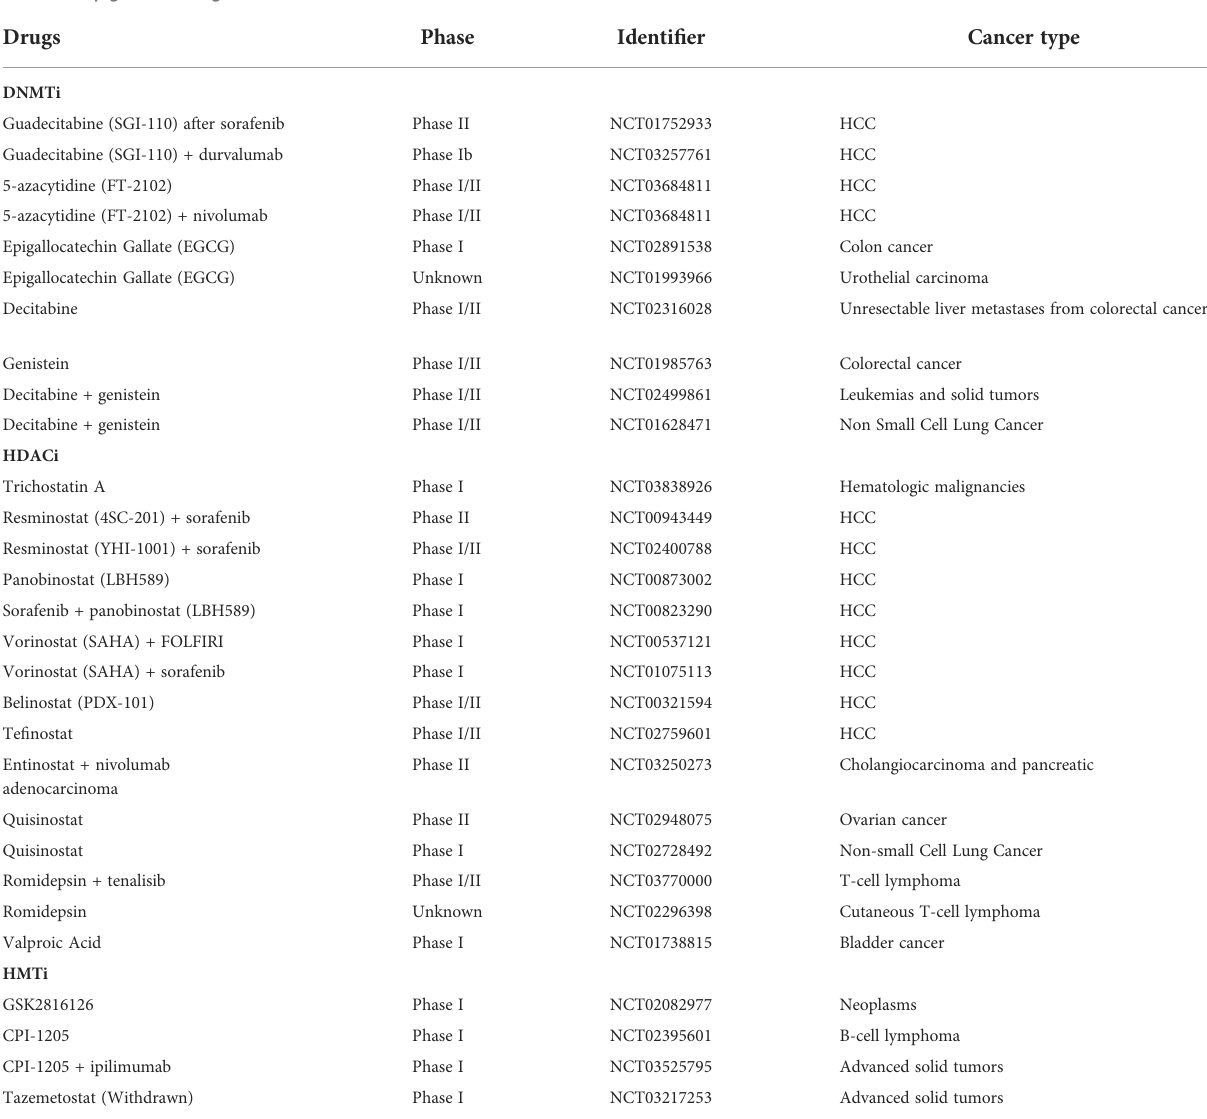
TABLE 2 Epigenetics drugs in clinical